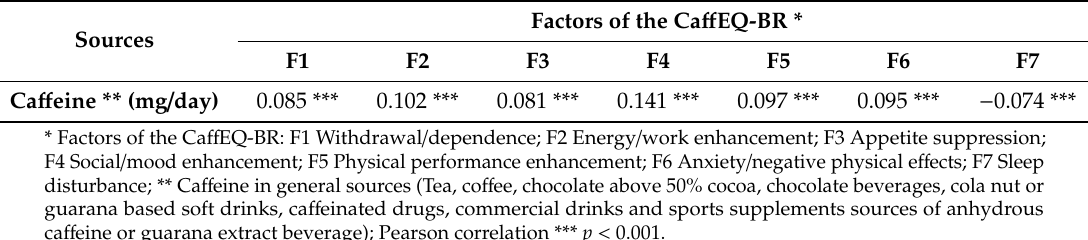
Table 4. Correlations Between Ca ff eine Expectancy Questionnaire in Brazil (Ca ff EQ-BR) Factors and Ca ff eine-Related Variables ( n =